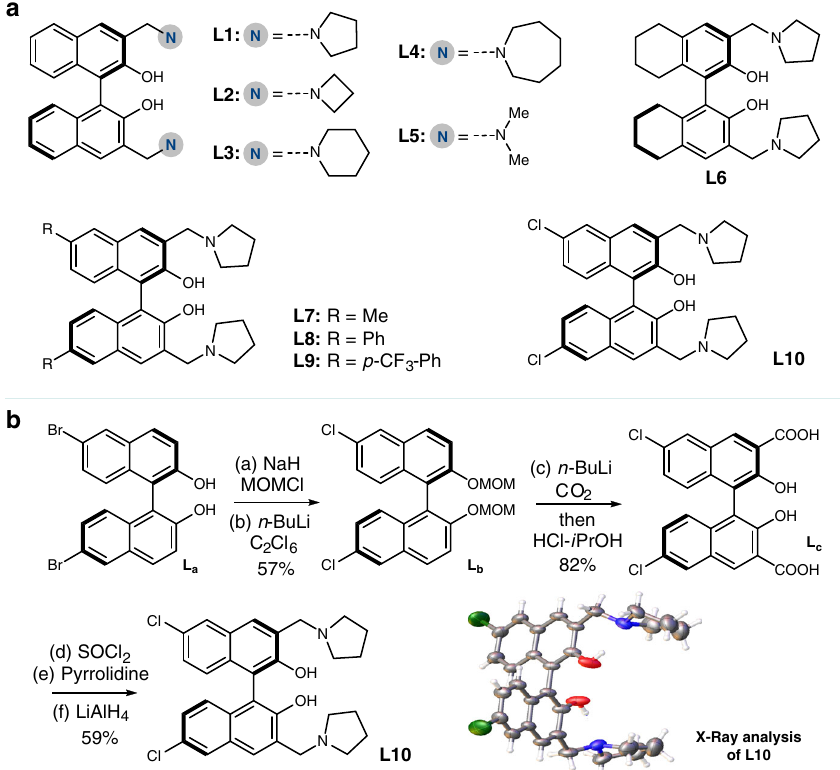
Fig. 2 Selection and development of bifunctional chiral ligands and related synthetic methods. a Bifunctional chiral ligands screened in the optimization process. b Synthetic method of chiral ligand L10 and related X-ray